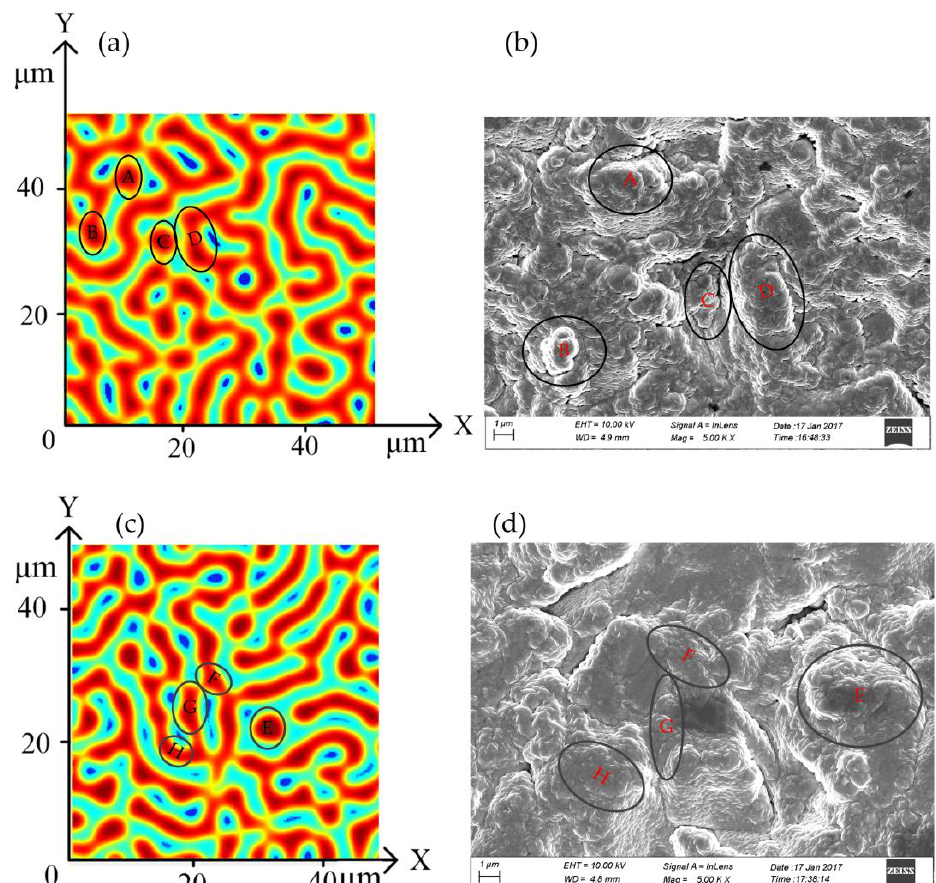
Figure 9. Top view of simulated and experimental microtopography. ( a , c ) Top view of simulation, and ( b , d ) top view of SEM.